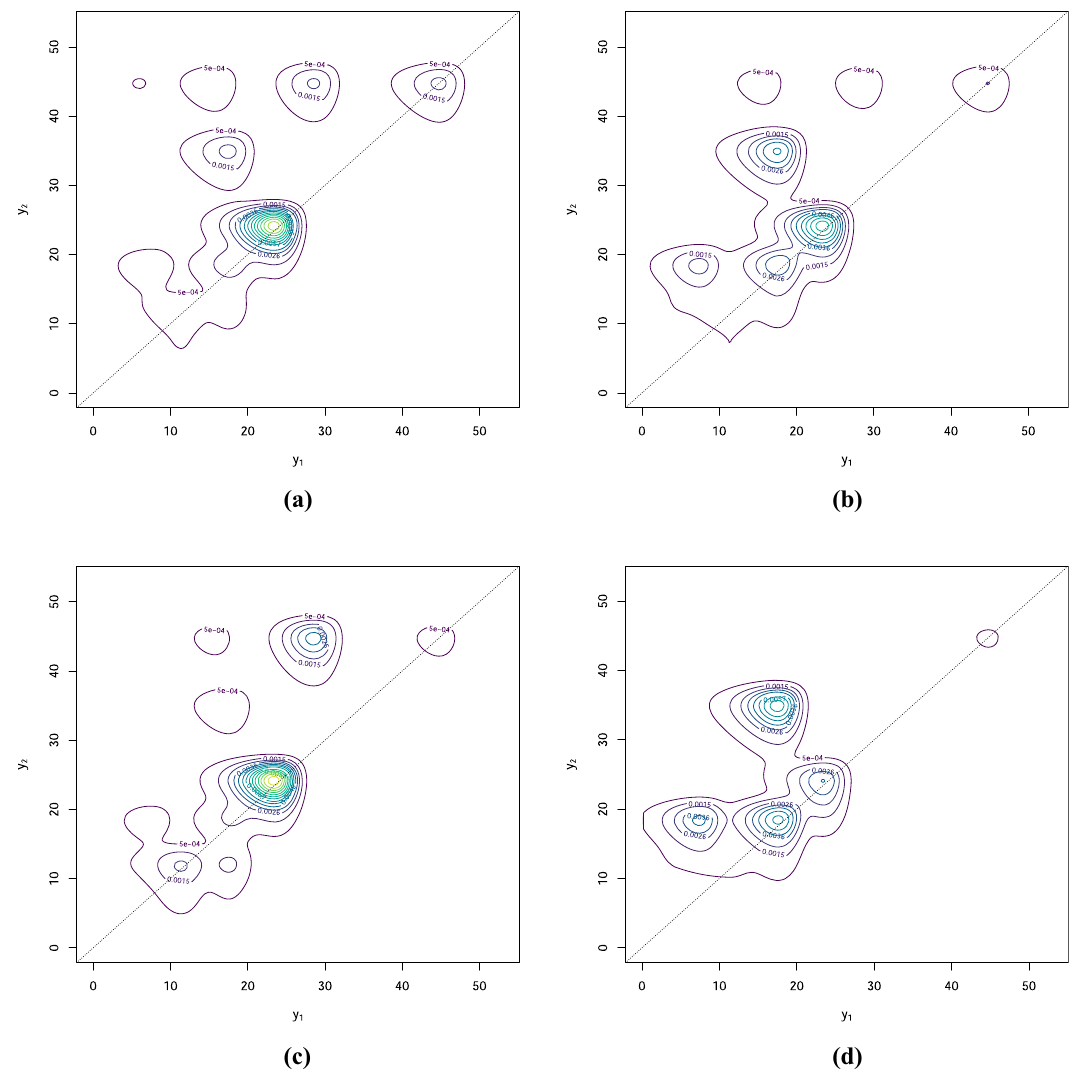
Figure 5: Contour plots of the bivariate lifetime densities for the four couples. ( a ) Couple 1, ( b ) Couple 2, ( c ) Couple 3, and ( d ) Couple